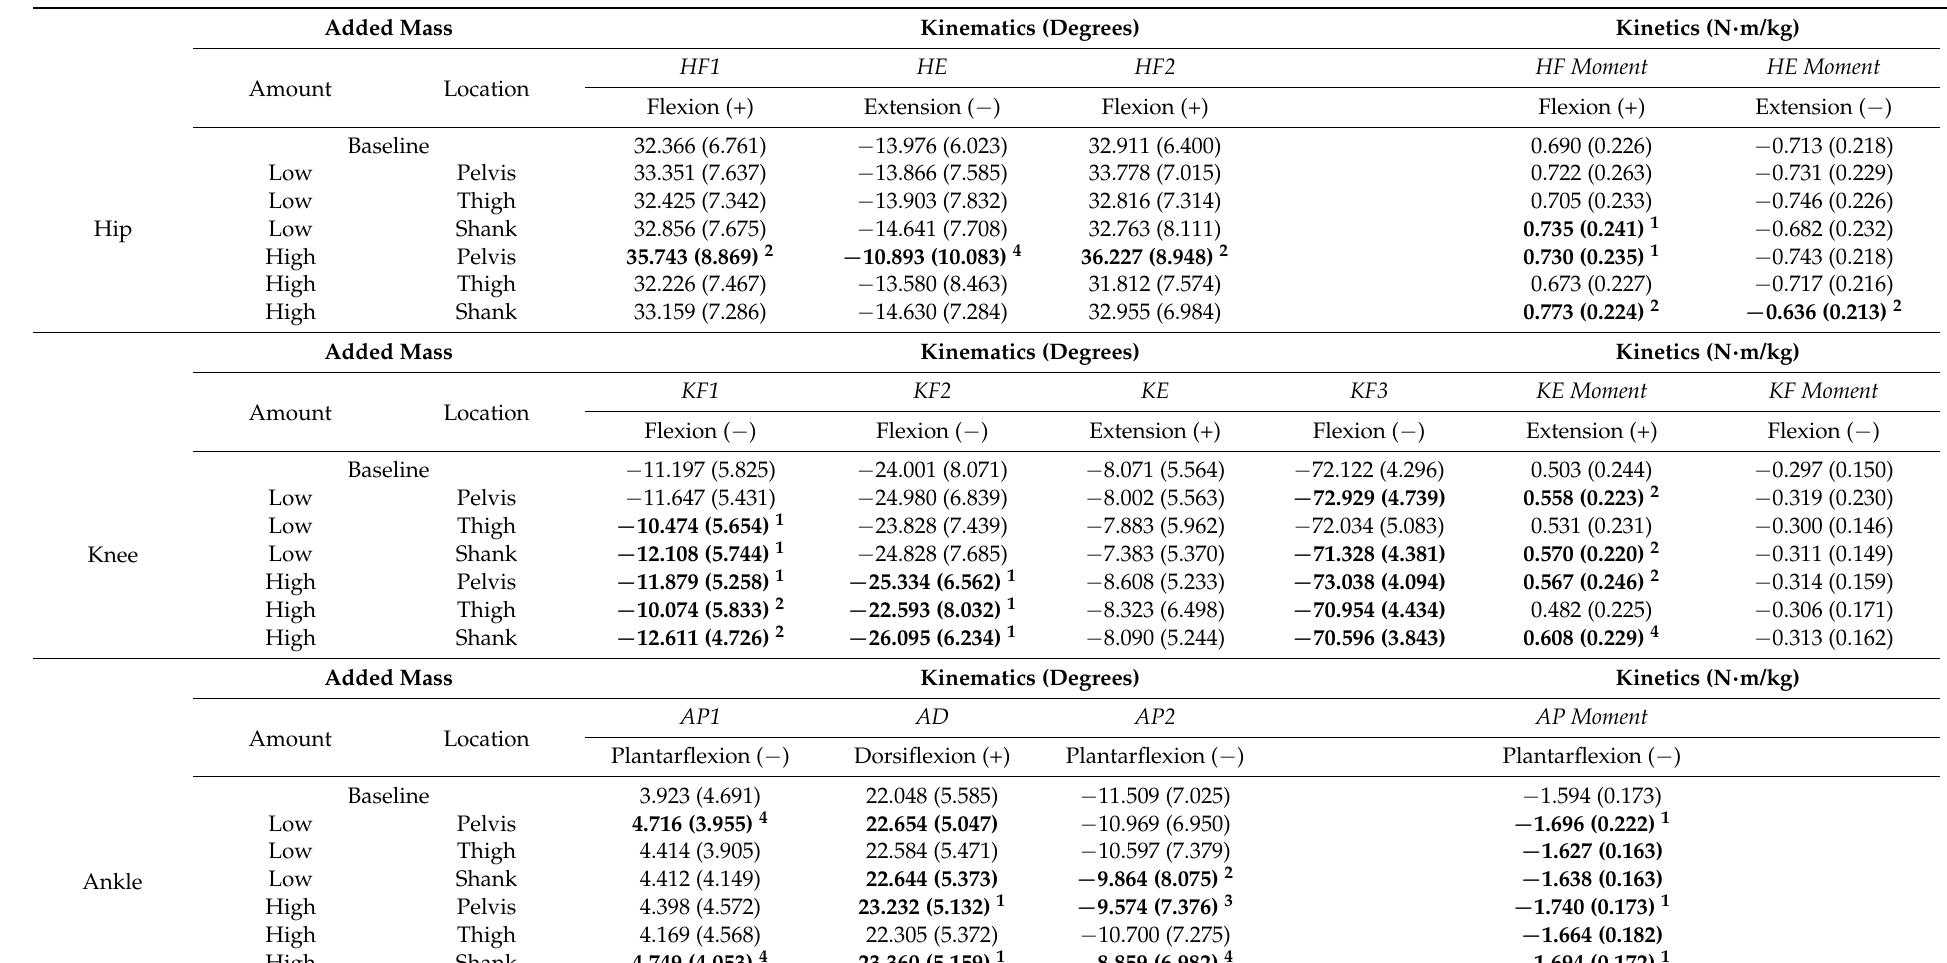
Table 3. Mean and Standard Deviation values of peak kinematic and kinetic